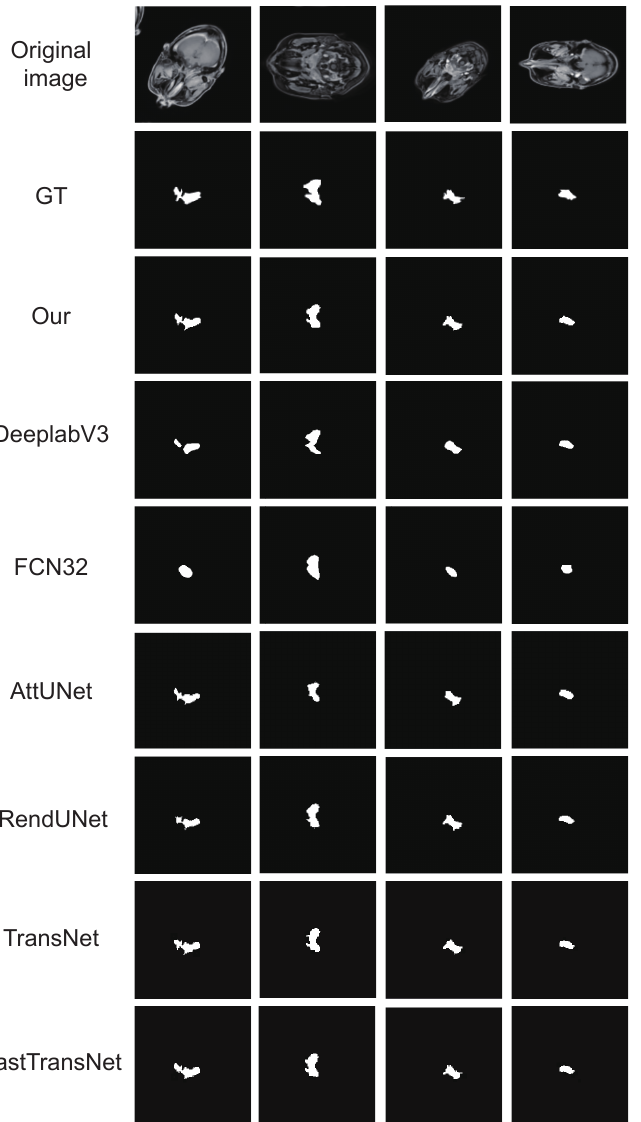
Figure 3. Examples of NPC segmentation results: We select four typical MRI images of nasopharyngeal carcinoma and present the segmentation results of our model and six models used for